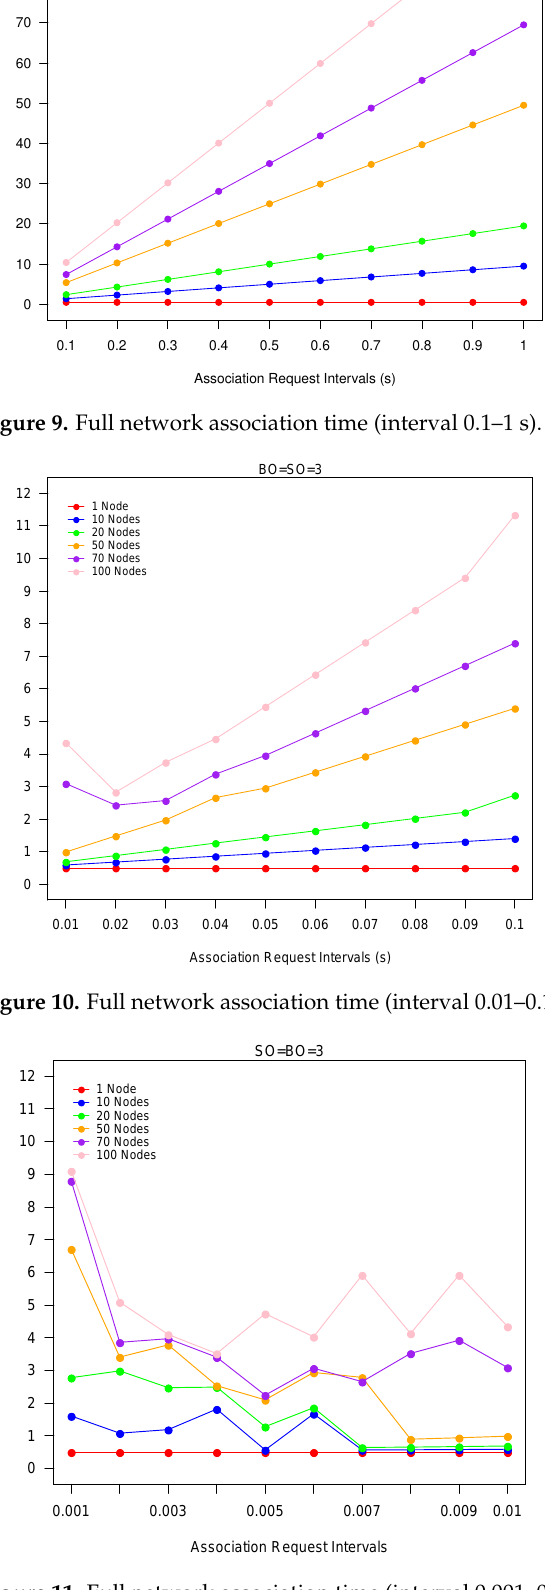
Figure 11. Full network association time (interval 0.001–0.01